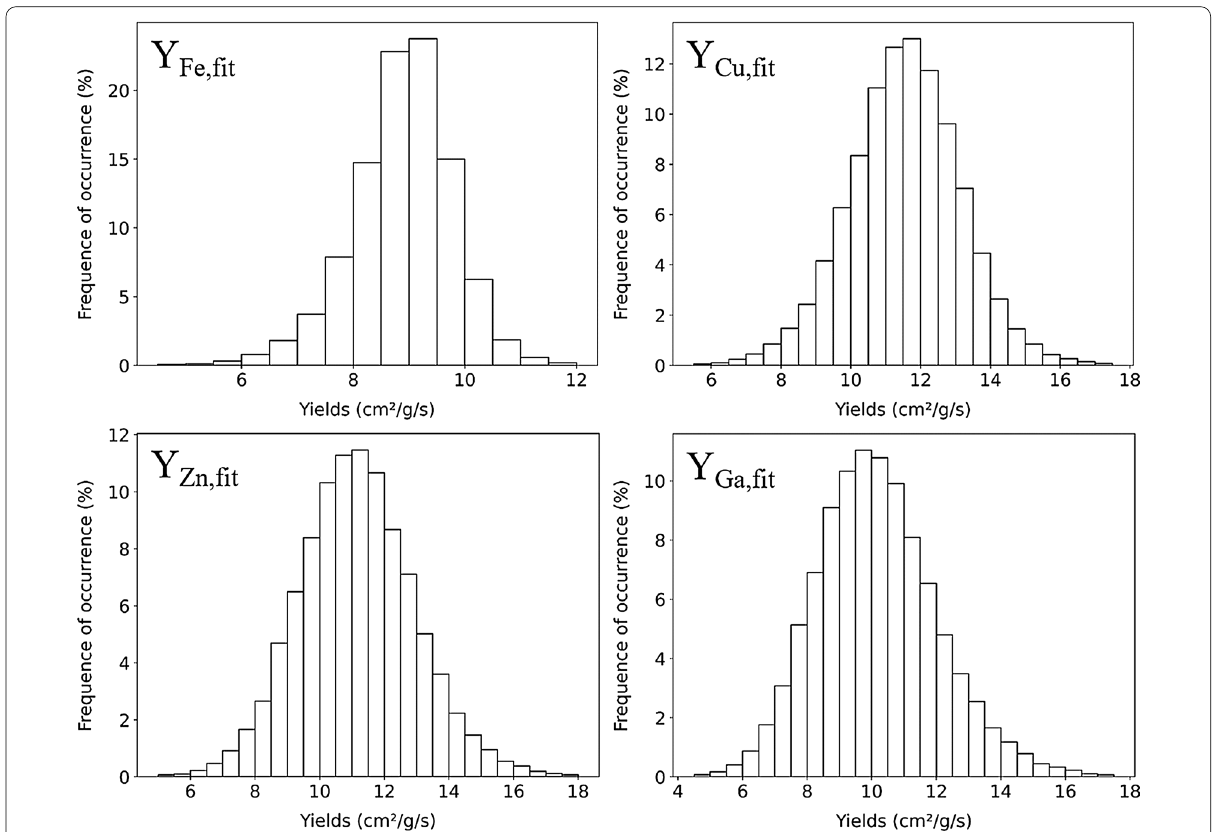
Fig. 7 Interpolated yield (cm 2 /g/s) distributions for Fe, Cu, Zn, and Ga based on ATHO‑G using 50,000 Monte Carlo